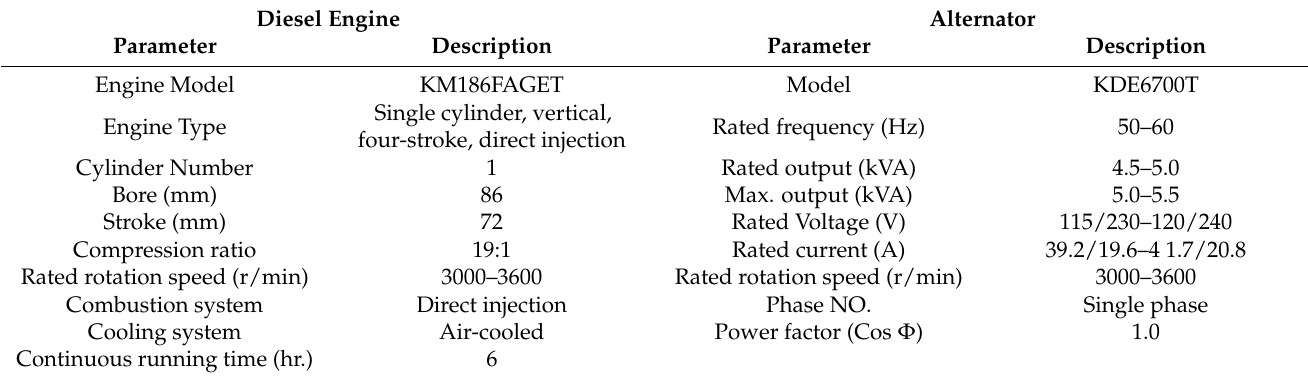
Table 3. Technical parameters of KM186FAGET and KDE 6700 T alternator. Adapted with the permission from [59], 2022, KIPOR UK.